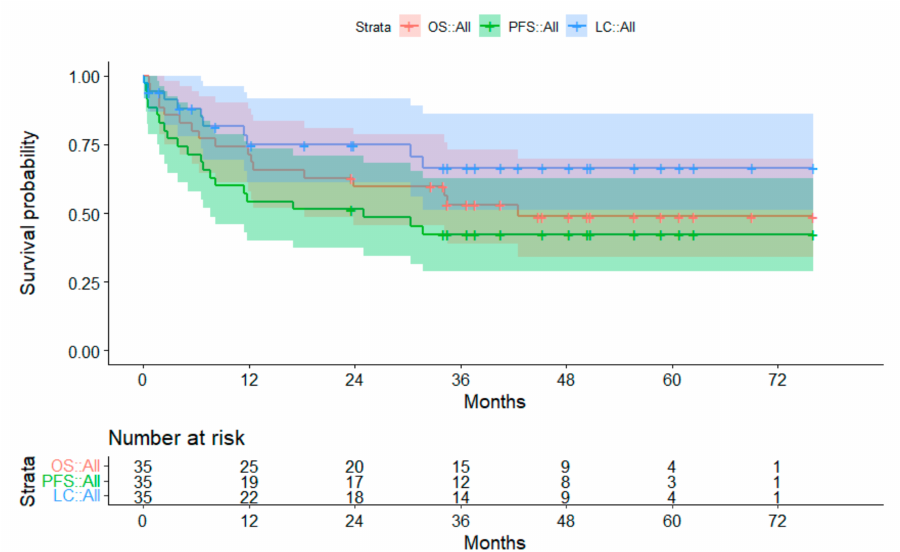
Figure 4. Survival curves for patients with atypical teratoid rhabdoid tumor. The 95% confidence intervals are displayed. Abbreviations: OS = overall survival; PFS = progression-free survival; LC = local